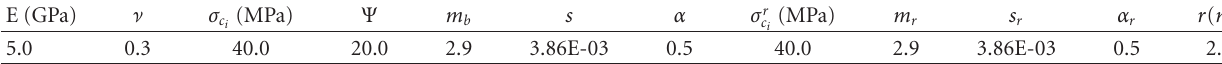
Table 1: Rock mass properties used in following discussion.